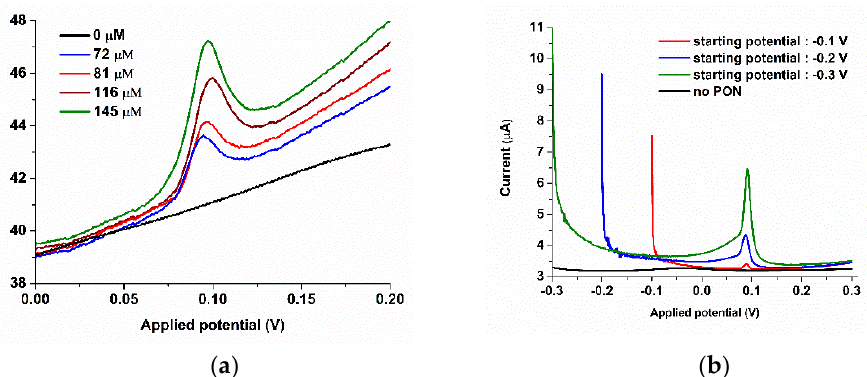
Figure 7. ( a ) LSV using SPCE/CoPc for the detection of PON, using droplets of analyte over the electrode, − 0.4 to 0.3 V (electrolyte: PBS pH 9 0.1M + 0.1 M KCl), using different PON concentrations. ( b ) DPV of the SPCE/CoPc in the presence (red, blue, green) and absence (black) of 125 µM of PON, using different negative starting potentials (−0.1 V, −0.2 V, and −0.3 V).